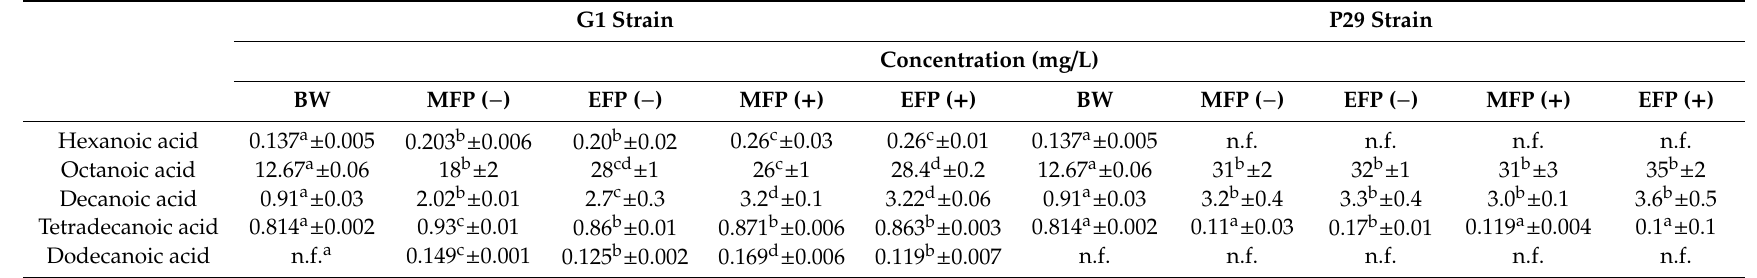
Table 4. Determination of the concentration (mg / L) of fatty acids involved in the synthesis of ethyl